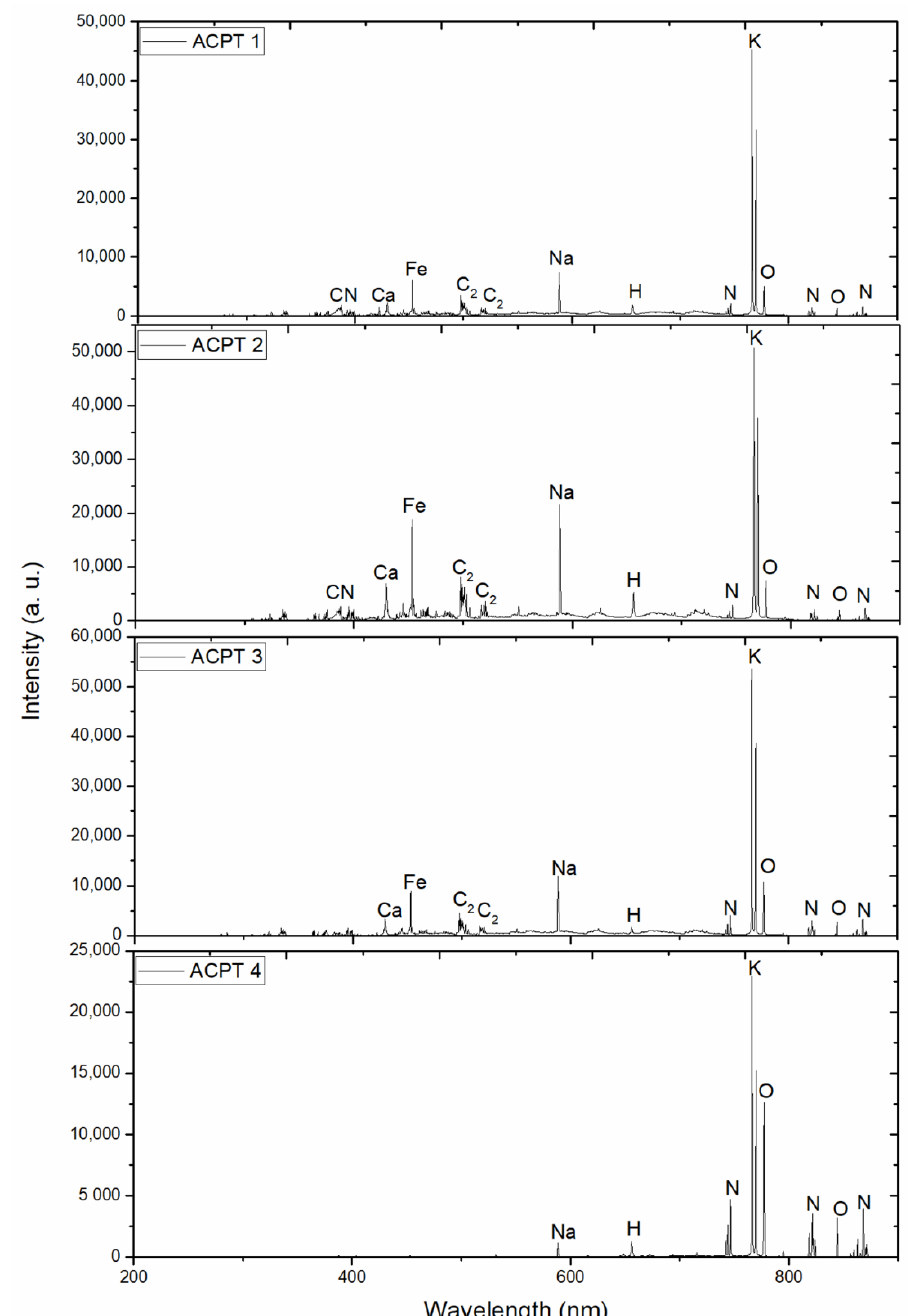
Figure 2. The mean spectrum of 70 LIBS spectra in the training set sample from each type of peni- cillin manufacturer. Table 2. Corresponding wavelengths of the elements or molecular bands in the penicillin LIBS spec- tra.